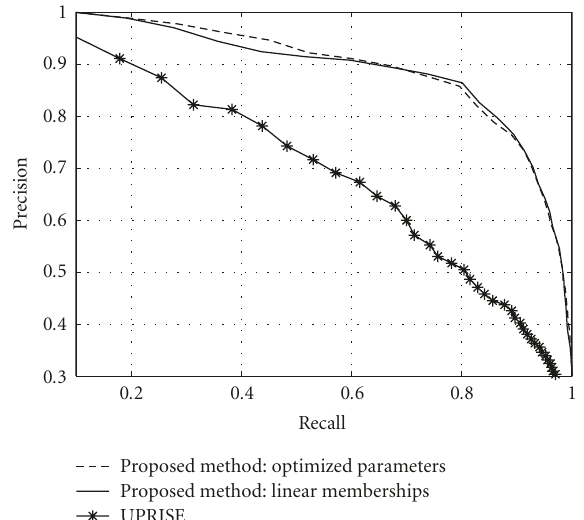
Figure 15: Precision-recall curves for the proposed method and